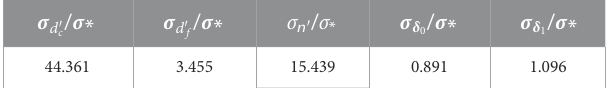
TABLE 5 Comparison of the standard deviation of σ * = 10 − 2 μ K of fi ltered CMB, foreground, noise, and actual 10 brightest point sources simulation residuals with unknown polarization direction in the pixel domain when r =